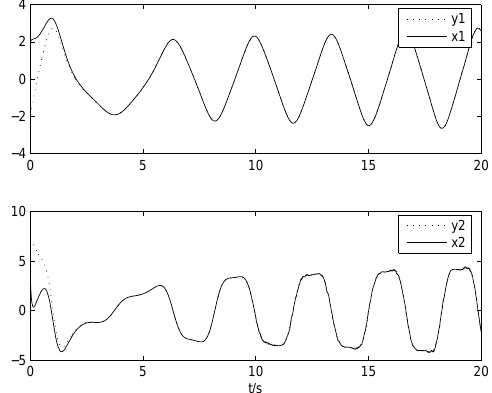
Figure 5: Time response of state variable of second order master-slave systems